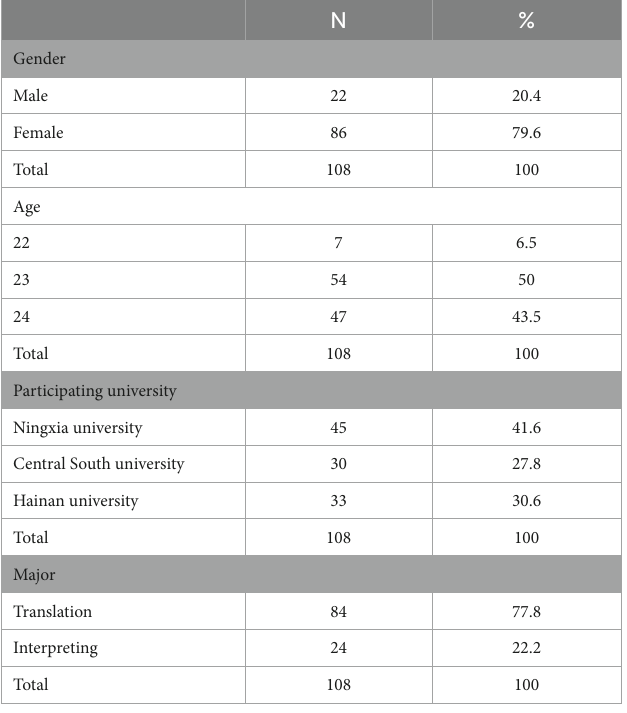
TABLE 2 Demographic characteristics of the